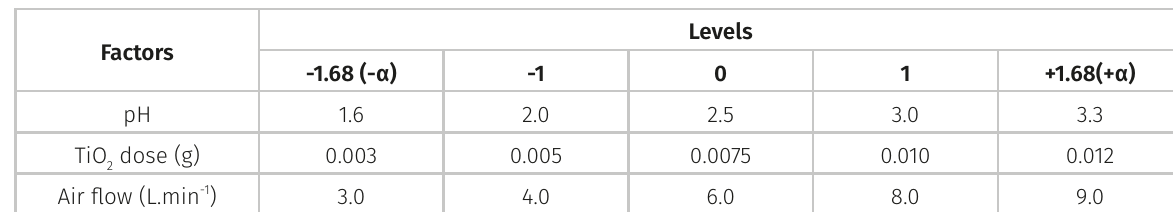
Table III . Variables and defined levels for the CCRD (2³) referring to the factors: pH; TiO (L.min -1